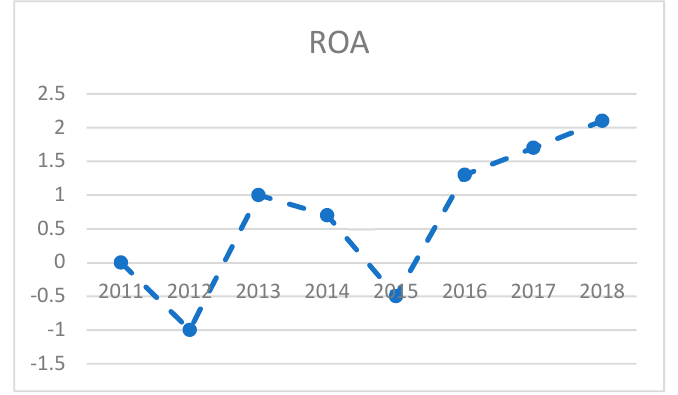
Figure 3. Fluctuations of average ROA over the years .